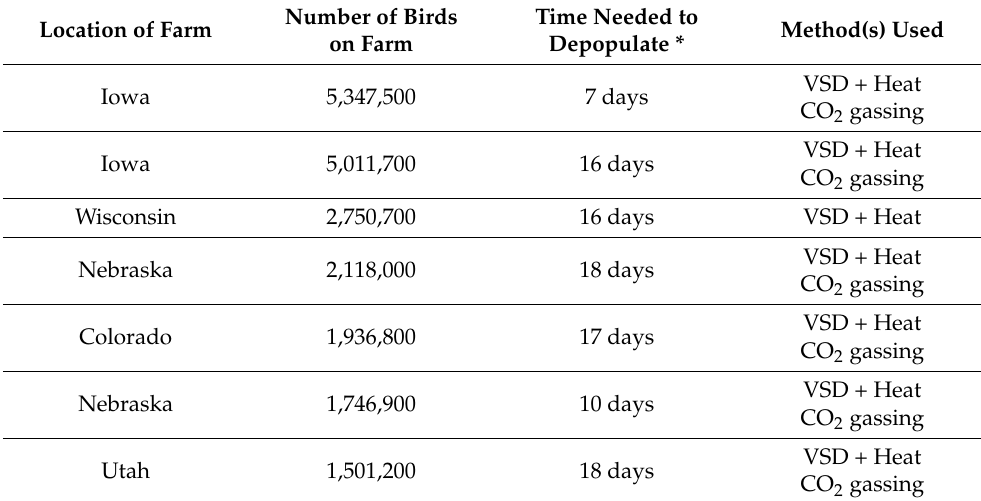
Table 1. 2022 HPAI Large Commercial Depopulations: Locations, Population Size, Time Needed to Depopulate, and Method(s) Used for the seven largest depopulations. All depopulations involved hens raised for egg production. (Time period: January–August). Number of Birds Time Needed to Location of Farm Method(s) Used on Farm Depopulate * VSD + Iowa 5,347,500 7 days